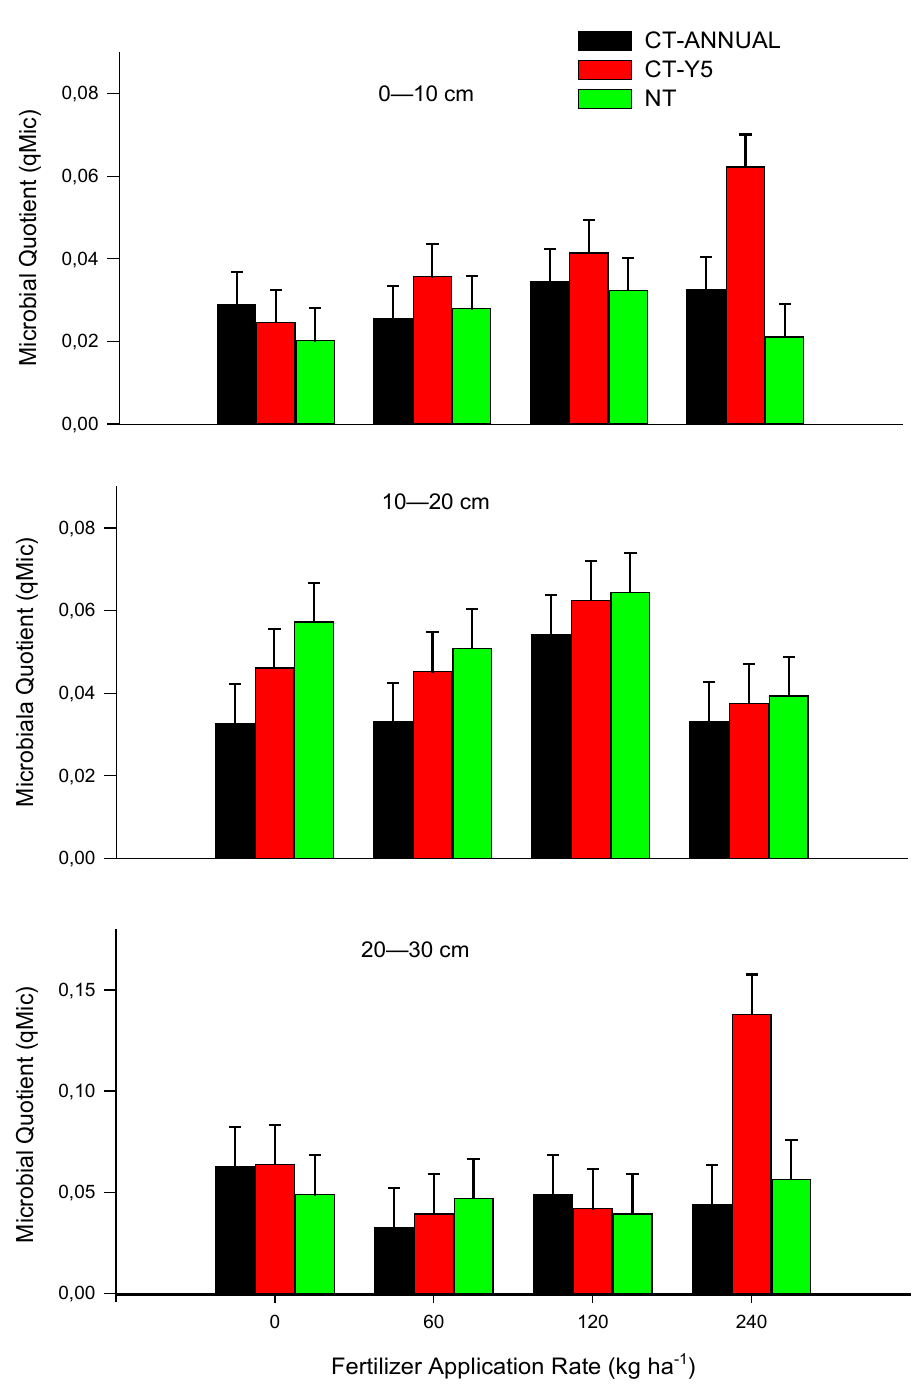
Figure 7. Variation of the microbial quotient of different soil depths.